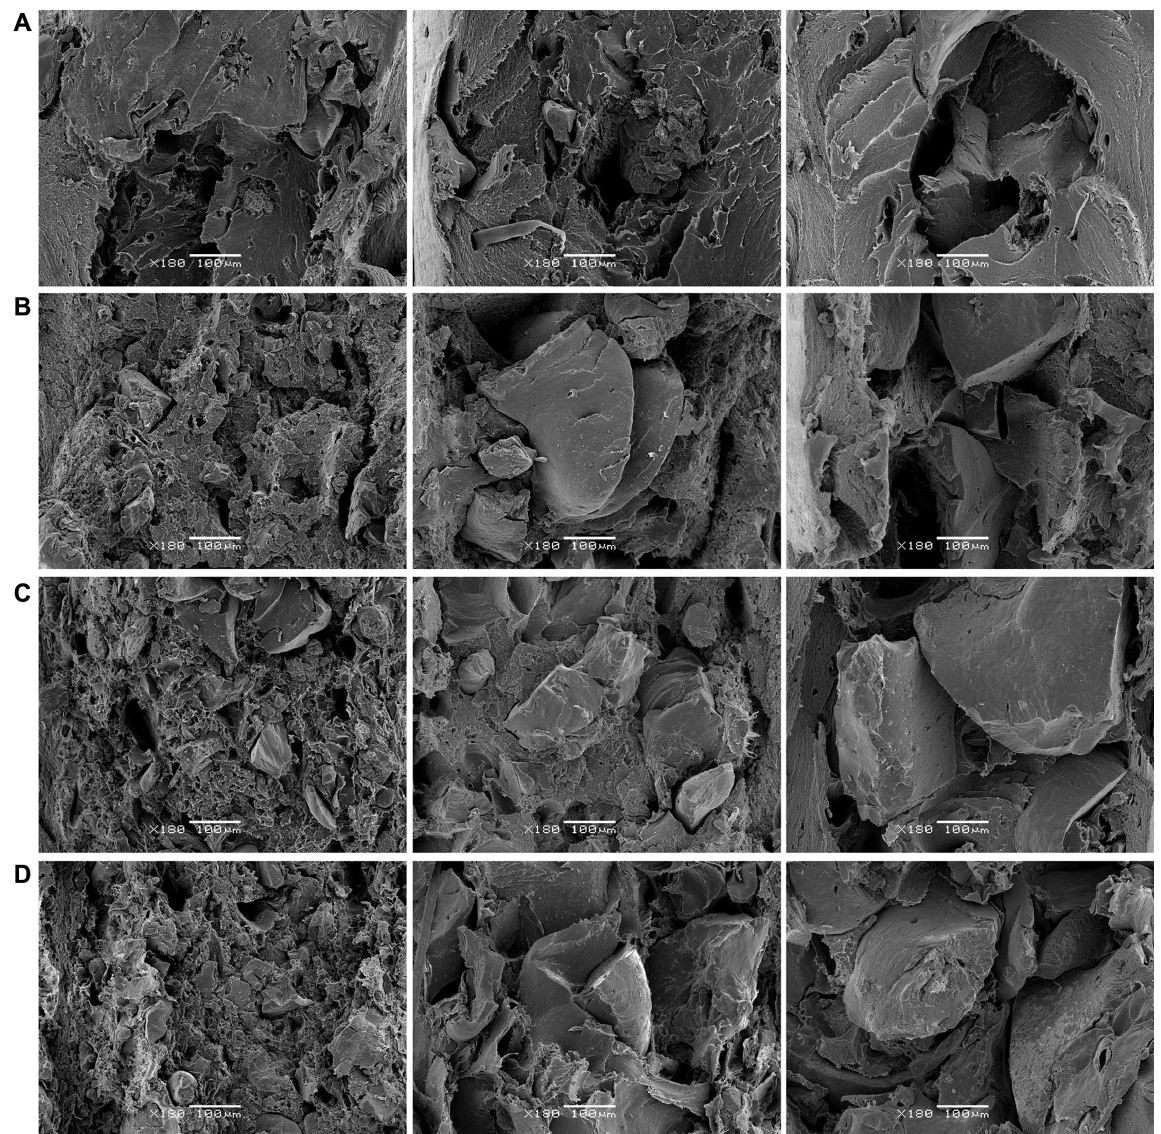
Figure 1 SEM micrographs of PS/GTR composites for some concentrations in GTR and particle sizes (first column, p < 200 μ m; second column, 200 μ m < p < 500 μ m; third column, p > 500 μ m. (A) PS/GTR-10%, (B) PS/GTR-20%, (C) PS/GTR-40% and (D)